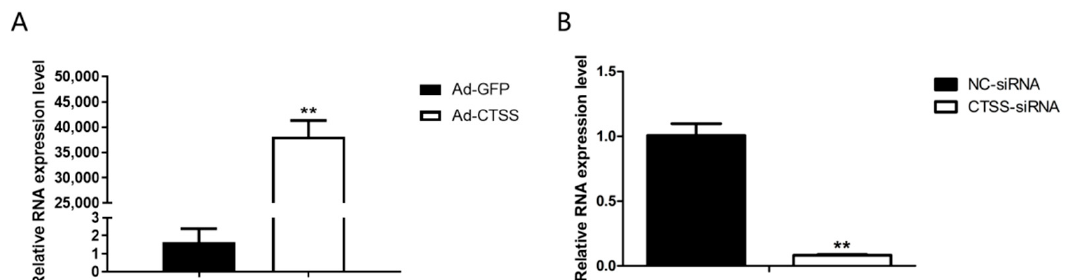
Figure 2. The efficiency of Ad ‐ CTSS and siRNA ‐ CTSS in rabbit GCS: ( A ): mRNA expression changes of CTSS after infec ‐ tion with Ad ‐ GFP. ( B ): mRNA expression changes of CTSS after transfection with siRNA ‐ CTSS . Values are presented as means± SEM for three biological replicates. ** p < 0.01.